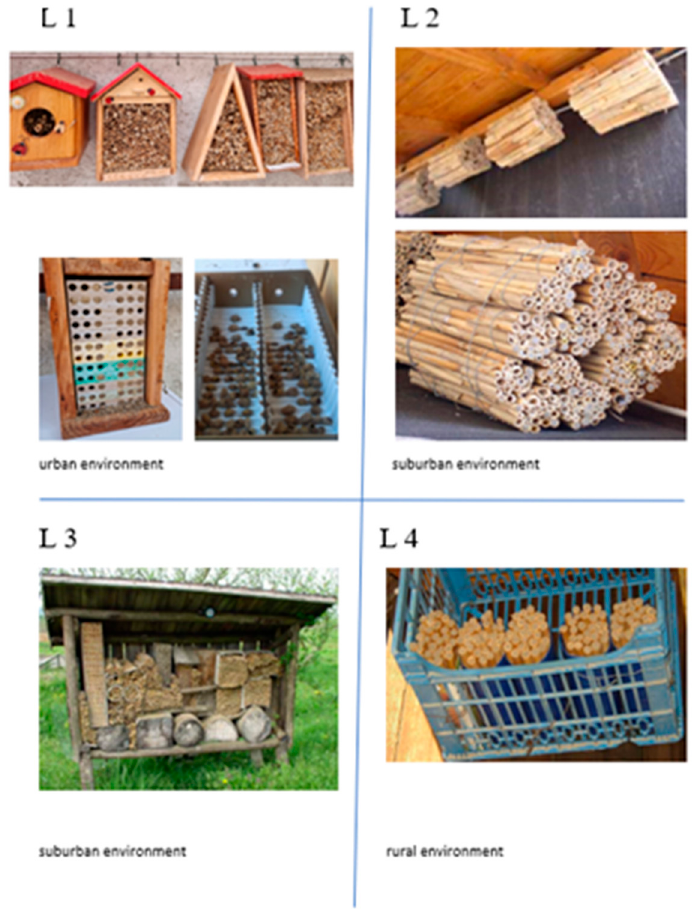
Figure 2. At semi-controlled rearing solitary bee stations (Location 1, Location 2, Location 3 and Location 4) different management practices were used.